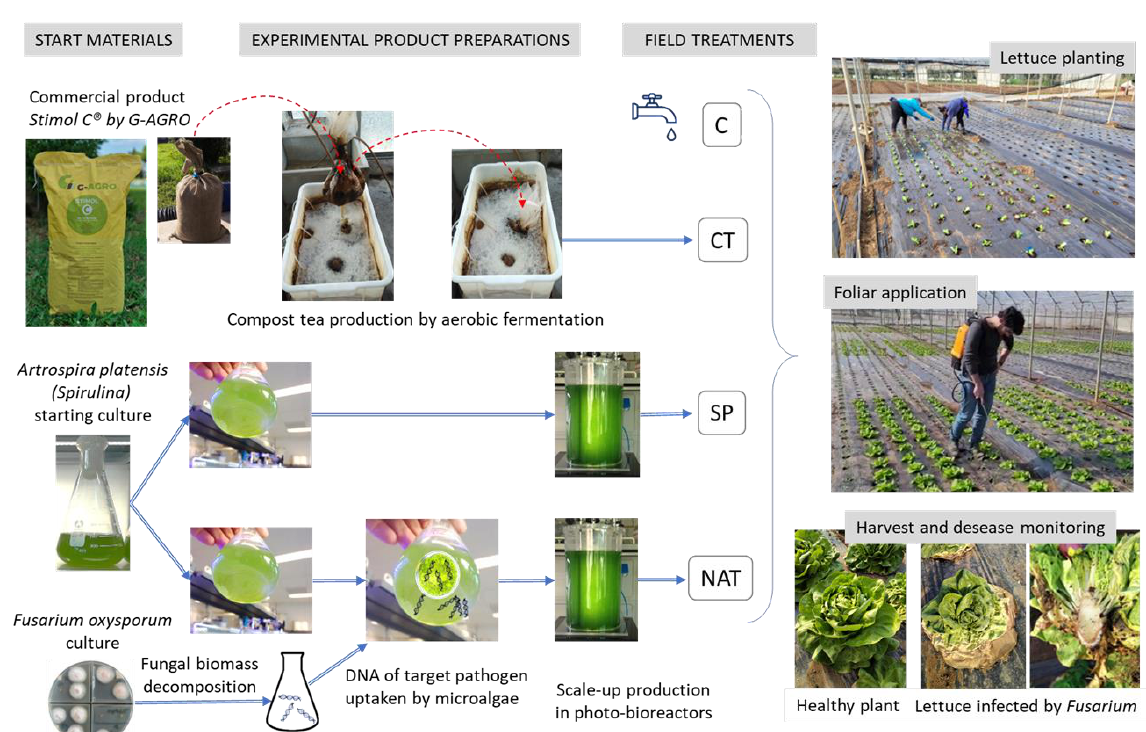
Figure 1. Schematic description of the experimental design of Lactuca sativa organic fertilization. Control plots were irrigated with pure water. Treatments were done by foliar application with a water solution of commercial compost tea (CT), spirulina (SP), and spirulina previously exposed to natural uptake of Fusarium DNA